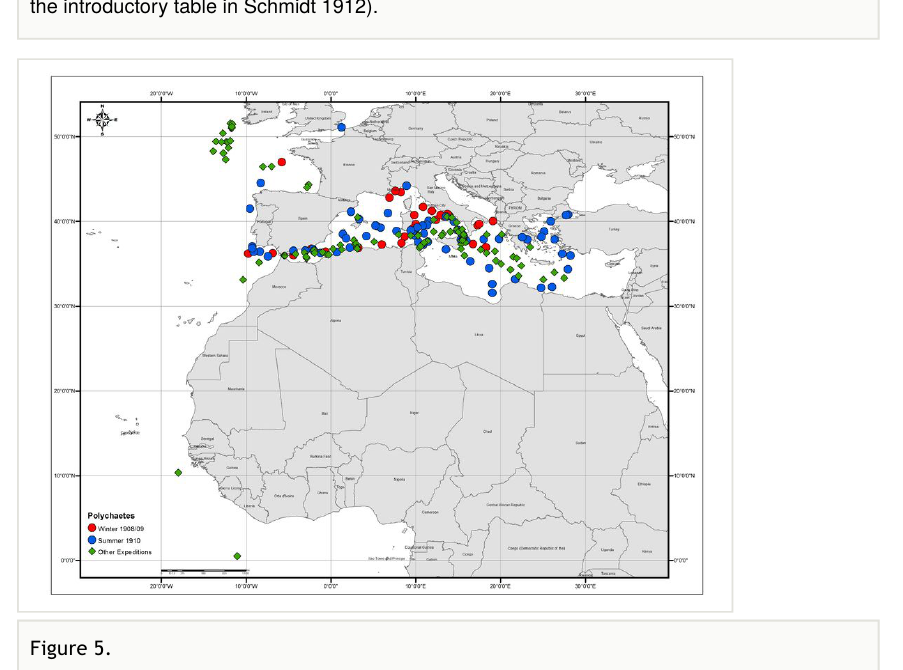
Map of sampling stations where pelagic polychaetes were